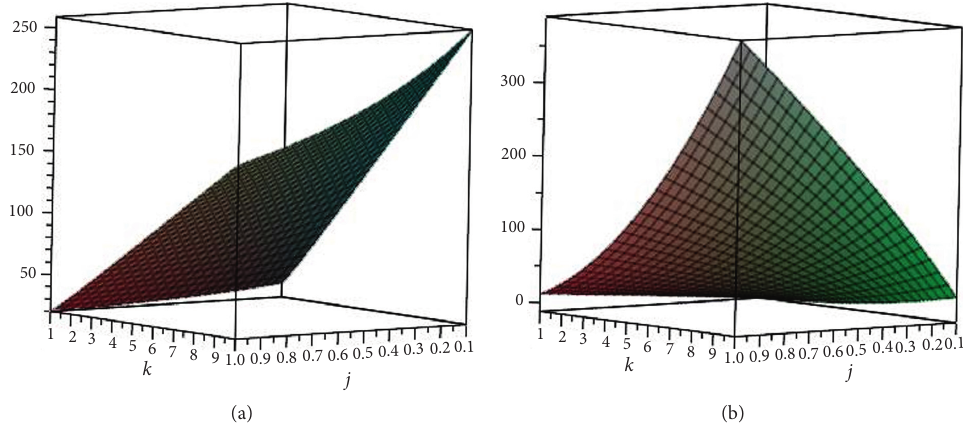
Figure 6: (a) Harmonic index for j ≥ k and α � 1. (b) Inverse sum index for j ≥ k and α �